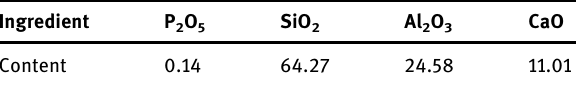
Table 3: Industrial analysis of reducing agent coke % ( wt )